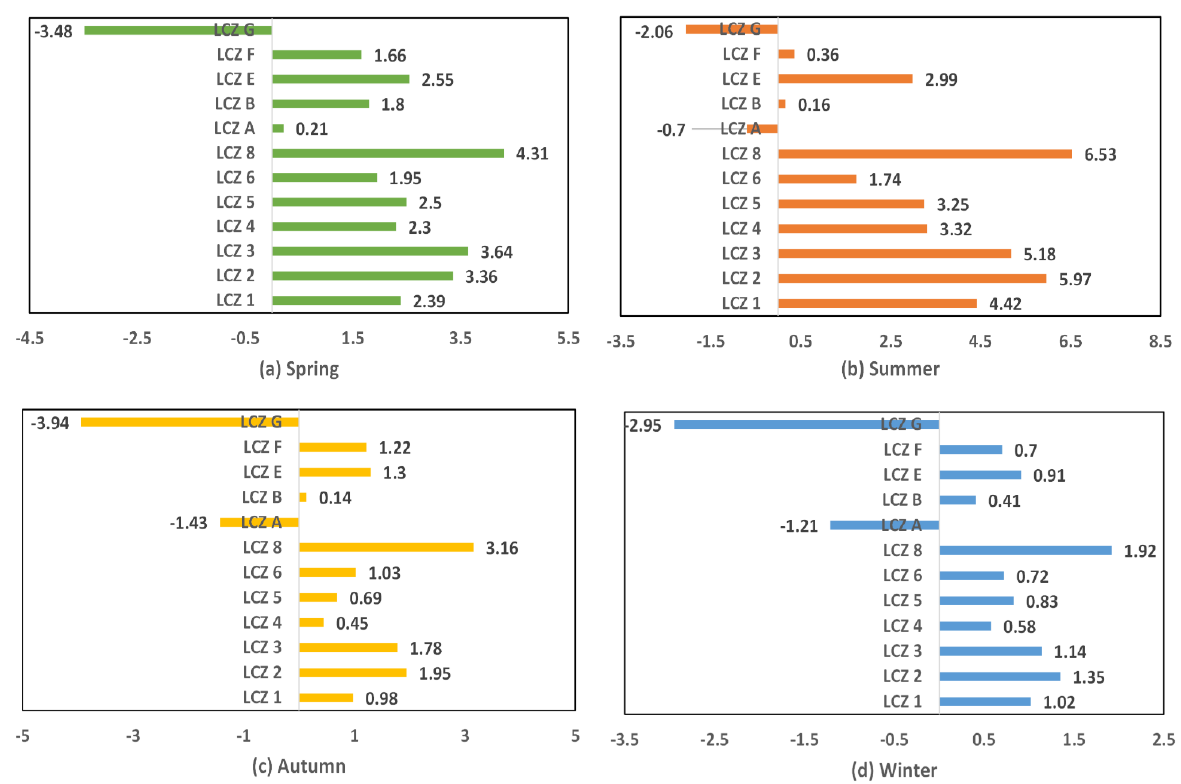
Figure 5. SUHI intensity in °C per LCZ class compared to LCZ D for all seasons.